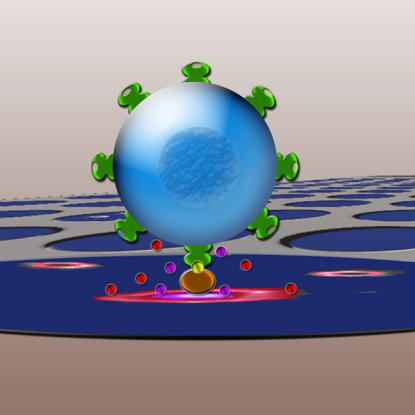
Catching antigen-specific T cells on a biological chip